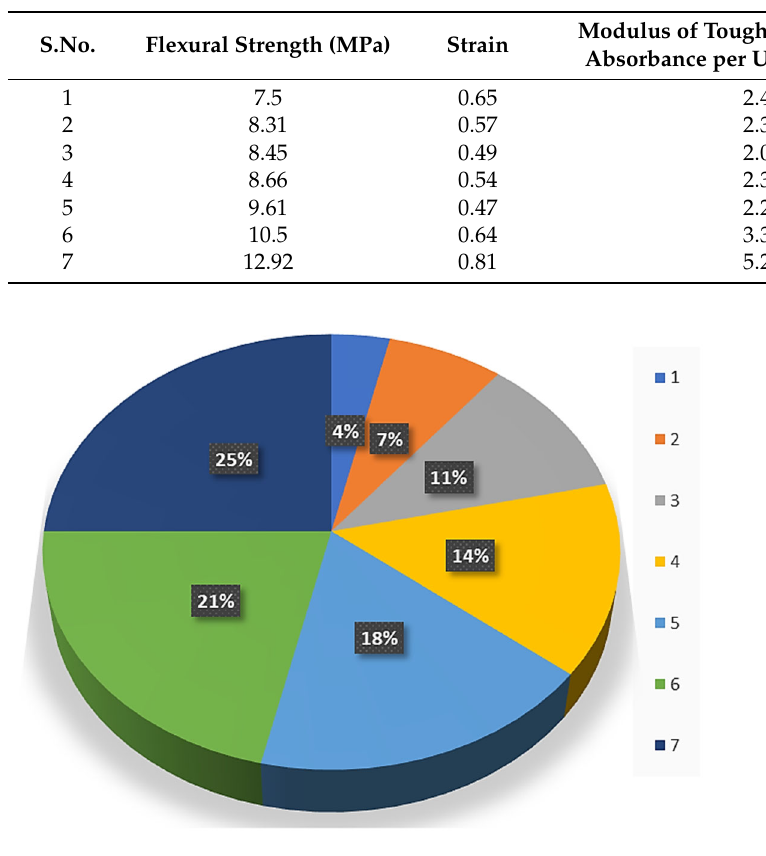
Figure 12. Strain absorbance capacity of the ATA specimens.